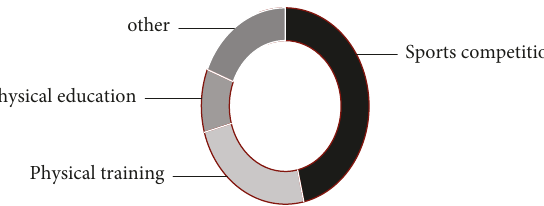
Figure 3: Application proportion of artificial intelligence in sports field. Table 1: Five health status